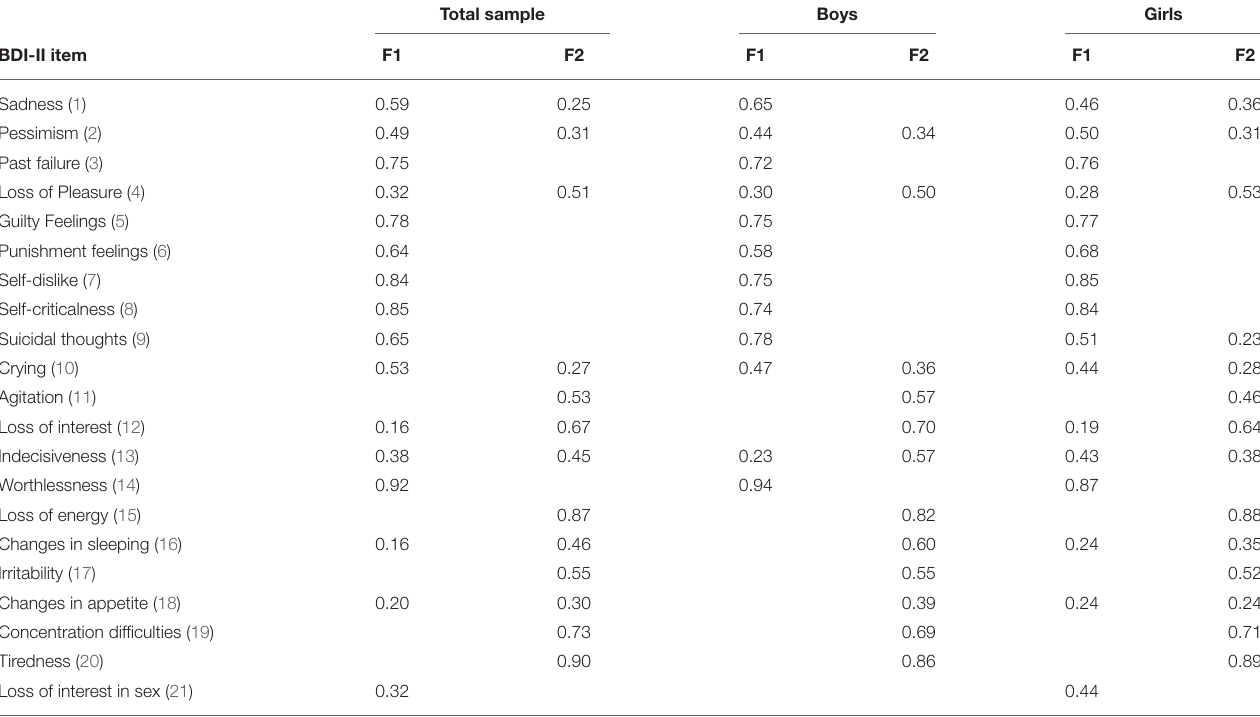
TABLE 4 | Factor loadings for the exploratory two-factor solution for the total sample ( n = 835) and according to gender (boys n = 345; girls n = 490). Total sample Boys